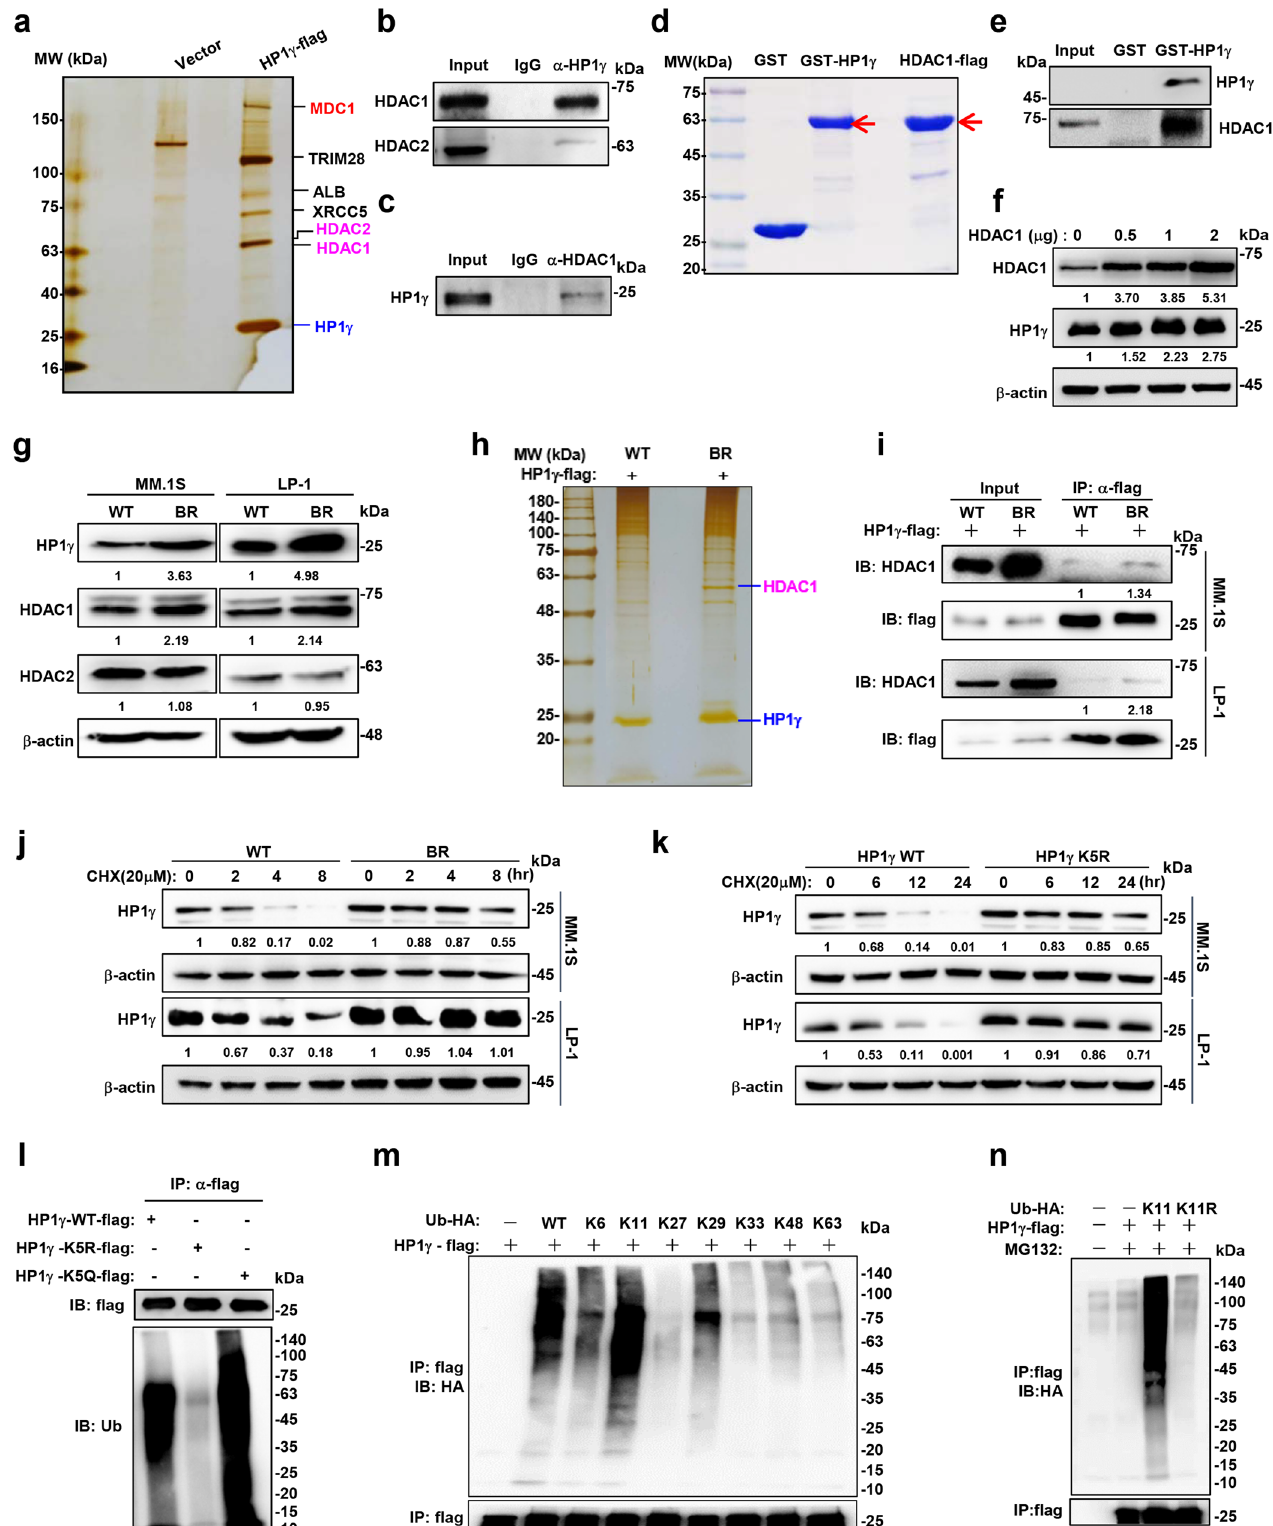
(Supplementary Fig. 6e), despite that overexpression of HP1 γ -K5R in MM cells indeed elicited stronger chemoresistance and proliferation (Supplementary Fig. 6f, g). Taken together, these results suggest that thenuclearcondensationofHP1 γ playsacriticalroleindrugresistance through DNA repair in MM cells, and this role does not depend on changes in the protein-protein